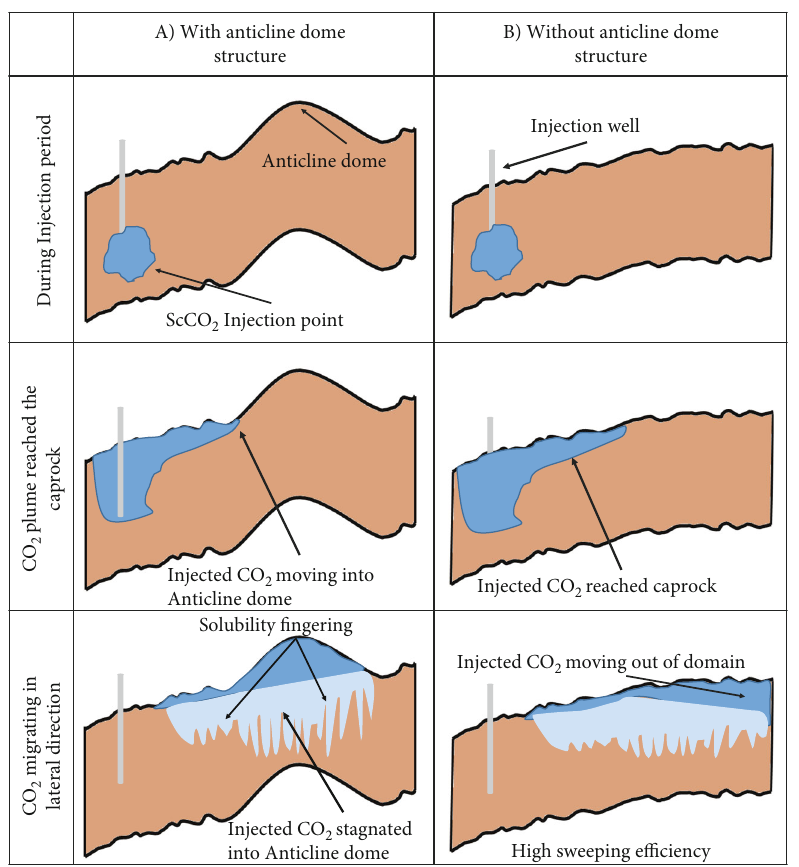
Figure 1: Schematic diagram explaining and illustrating the signi fi cance and in fl uence of geological features like anticline dome on sweeping e ffi ciency and solubility fi ngering phenomena during geologic CO 2